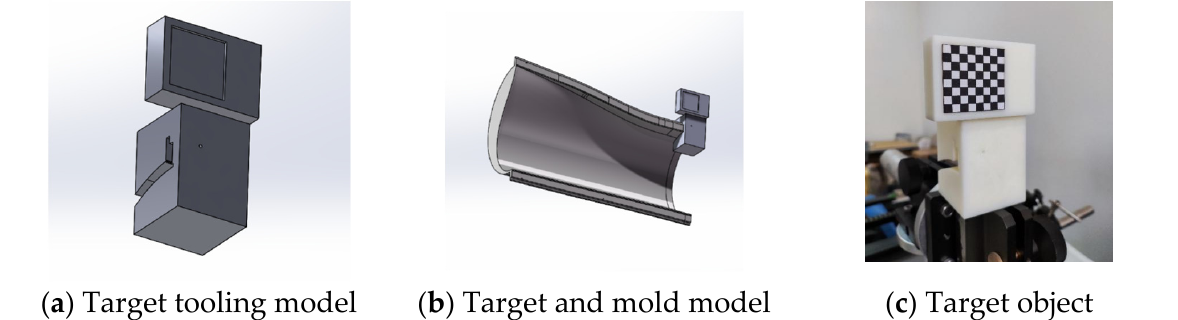
Figure 8. Molds and target models with target patterns pasted onto them.